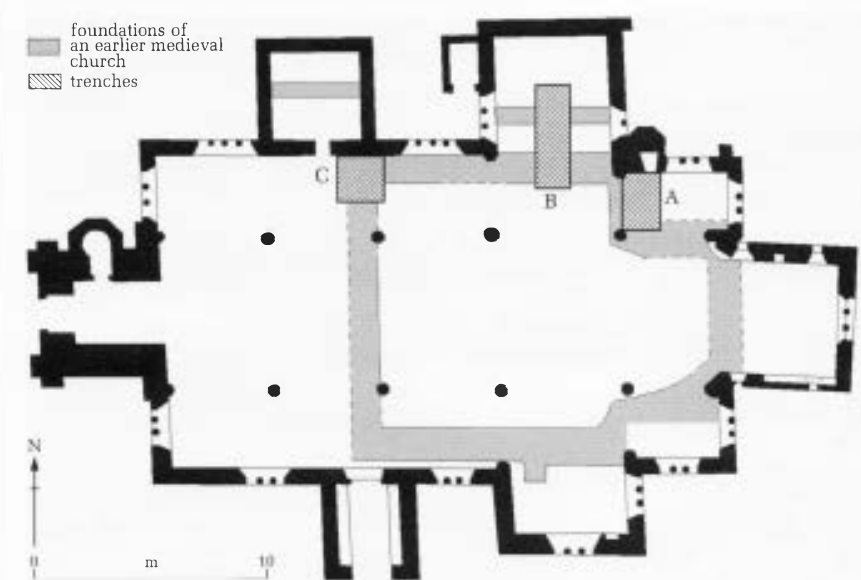
Plan of Holy Trinity church showing the location of trenches A, Band C; note at the east end of the church the outline of a semi-circular apse, which was revealed by the survey. GPR